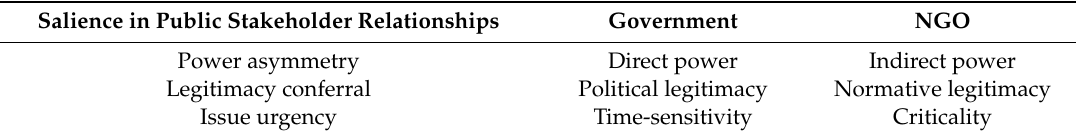
Table 1. Salience in relationships with the government and non-governmental organizations